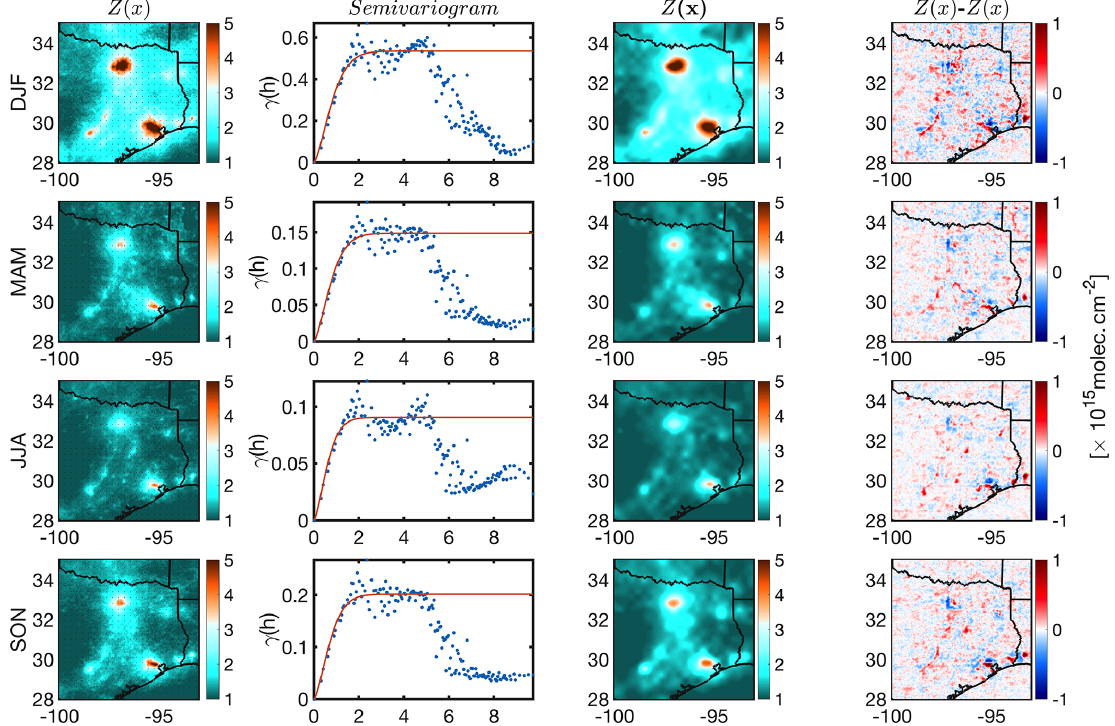
Figure 10. First column: the spatial distribution of TROPOMI tropospheric NO 2 columns oversampled in four different seasons in 2019 at 3 × 3km 2 spatial resolution. Second column: the corresponding semivariogram from samples selected from uniform 30 × 30km 2 blocks (shown with black dots in the first column) along the fitted stable Gaussian model (red line). Third column: the kriging estimates. Fourth column: the kriging estimates’ differences with respect to the observations.